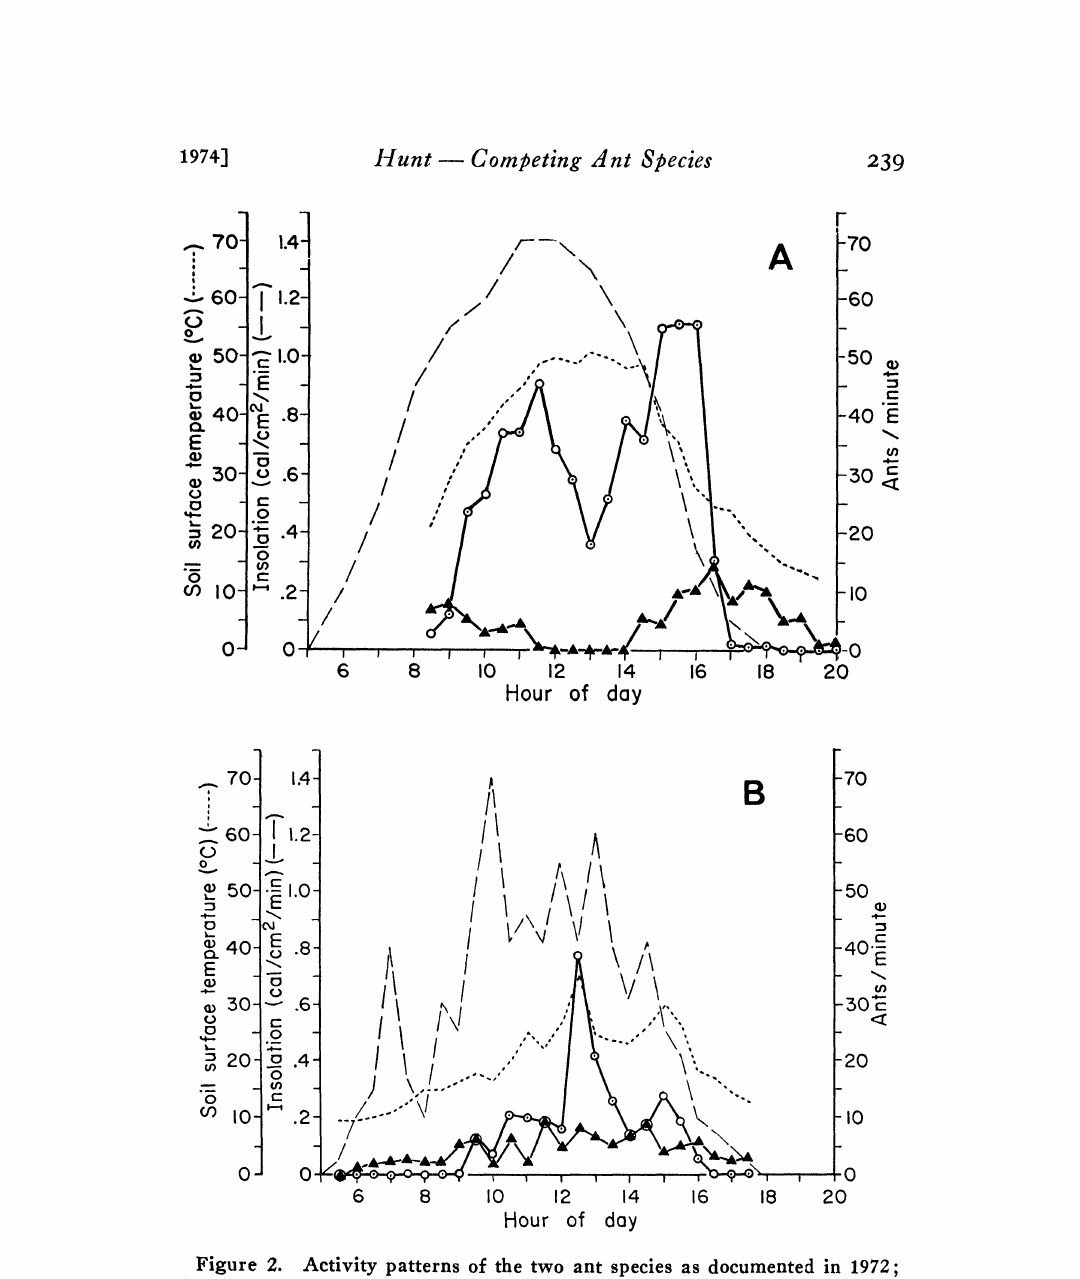
Figure 2. Activity patterns ot the two ant species as documented in 1972; A- 4 October, B 5 October. Triangles- Dorytnyrmex antarcticus; circles = Ta#inoma antarcticum (both in ants per minute passing nest opening); dotted line = soil surface temperature (C); dashed line solar intensity